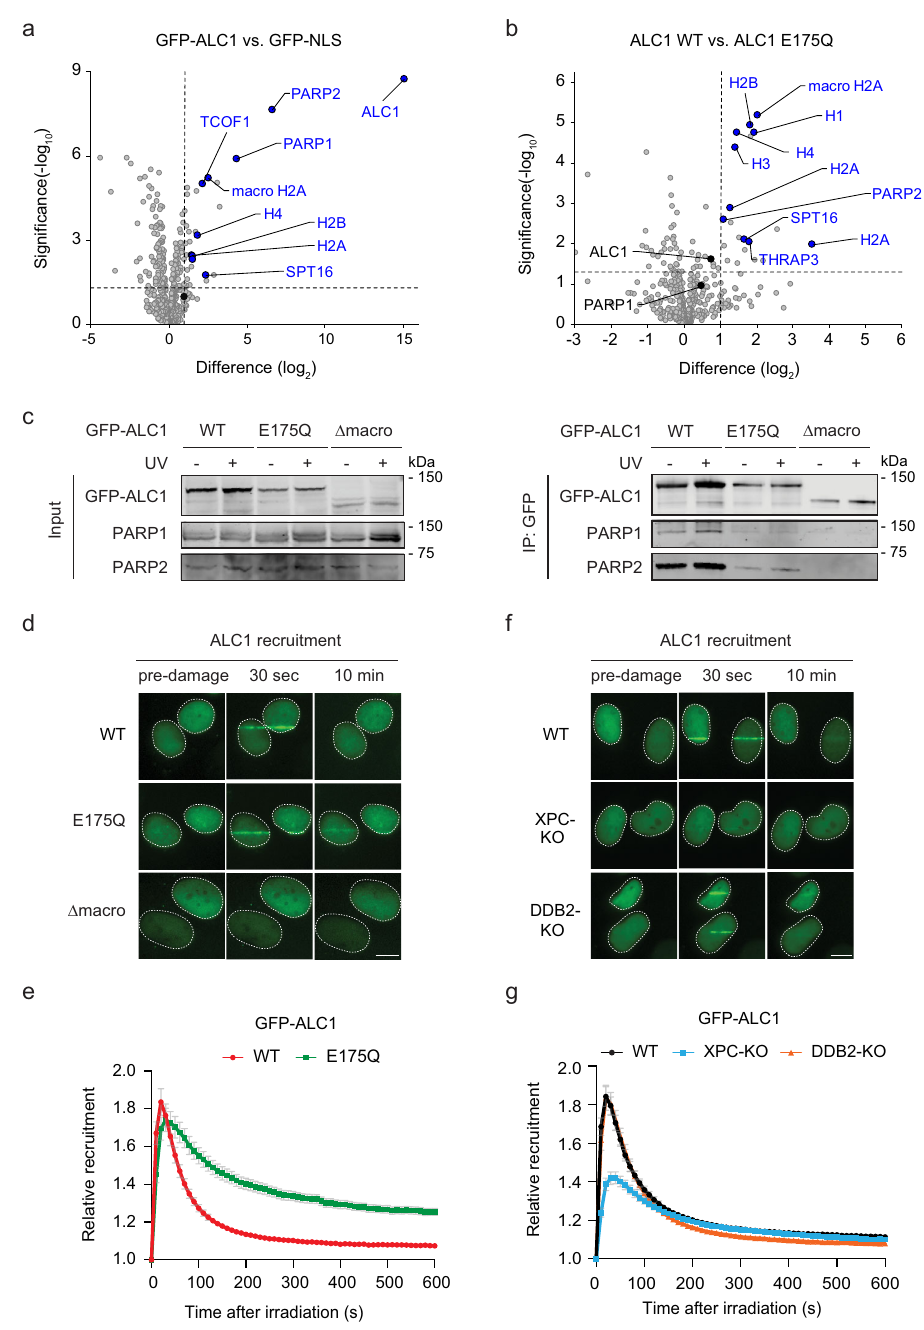
Fig. 7 The chromatin remodeler ALC1 is recruited to UV lesions by XPC. a Volcano plot displaying the interactomes of GFP-ALC1 over GFP-NS after GFP- pull-down from U2OS (FRT) ALC1-KO cells and analysis by label-free proteomics. b Differential interactome of GFP-ALC1 WT vs. the catalytic-de fi cient GFP-ALC1 E175Q mutant. a , b The dashed lines indicate a twofold enrichment on the x axis (log 2 of 1) and a signi fi cance of 0.05 ( − log 10 P value of 1.3; two- sided t test) on the y axis. c Co-IP of GFP-ALC1 WT, GFP-ALC1 E175Q, and a PAR-binding-de fi cient GFP-ALC1 Δ macrodomain in the presence and absence of UV-C (20 J/m 2 , 1 h). Three independent replicates of each IP experiment were performed obtaining similar results. d Representative images and e recruitment kinetics of GFP-ALC1 WT, GFP-ALC1 E175Q, GFP-ALC1 Δ macrodomain at sites of local UV-C laser irradiation in U2OS (FRT) ALC1-KO cells. 77 – 82 cells were analyzed in three independent experiments. f Representative images and g recruitment kinetics of GFP-ALC1 at sites of local UV-C laser irradiation in U2OS (FRT) WT, XPC-KO, and DDB2-KO cells. 107 – 135 cells were analyzed in n = 4 (WT), n = 5 (XPC-KO) or n = 6 (DDB2-KO) independent experiments. The data are shown as mean + SEM normalized to pre-damage GFP intensity at micro-irradiation sites. The scale bar in d , f is 5 µ